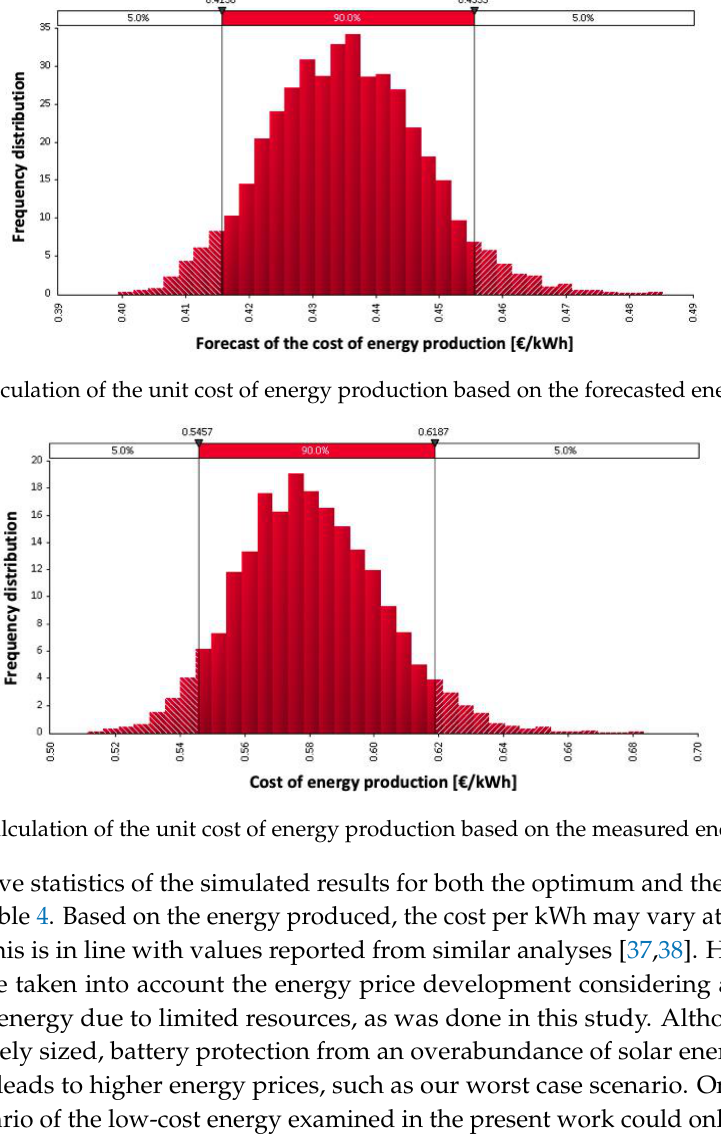
Figure 10. Calculation of the unit cost of energy production based on the measured energy values.